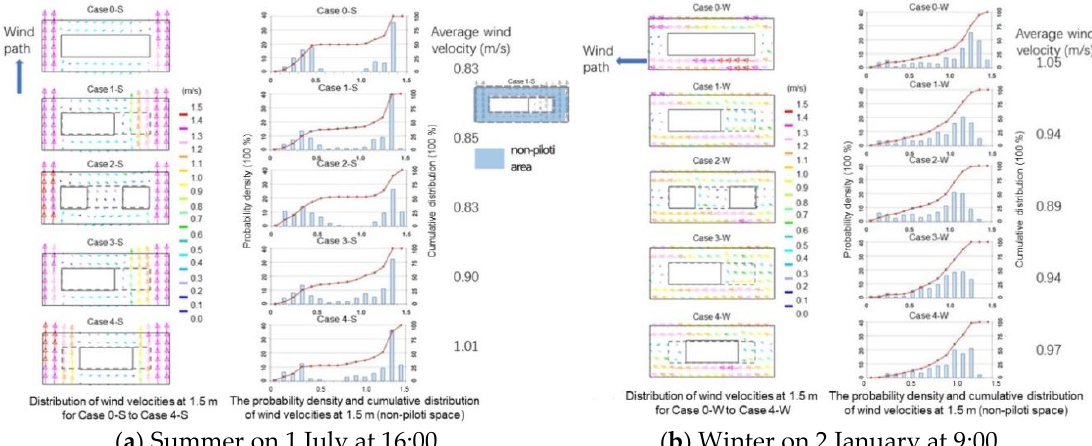
Figure 8. The wind velocity results.